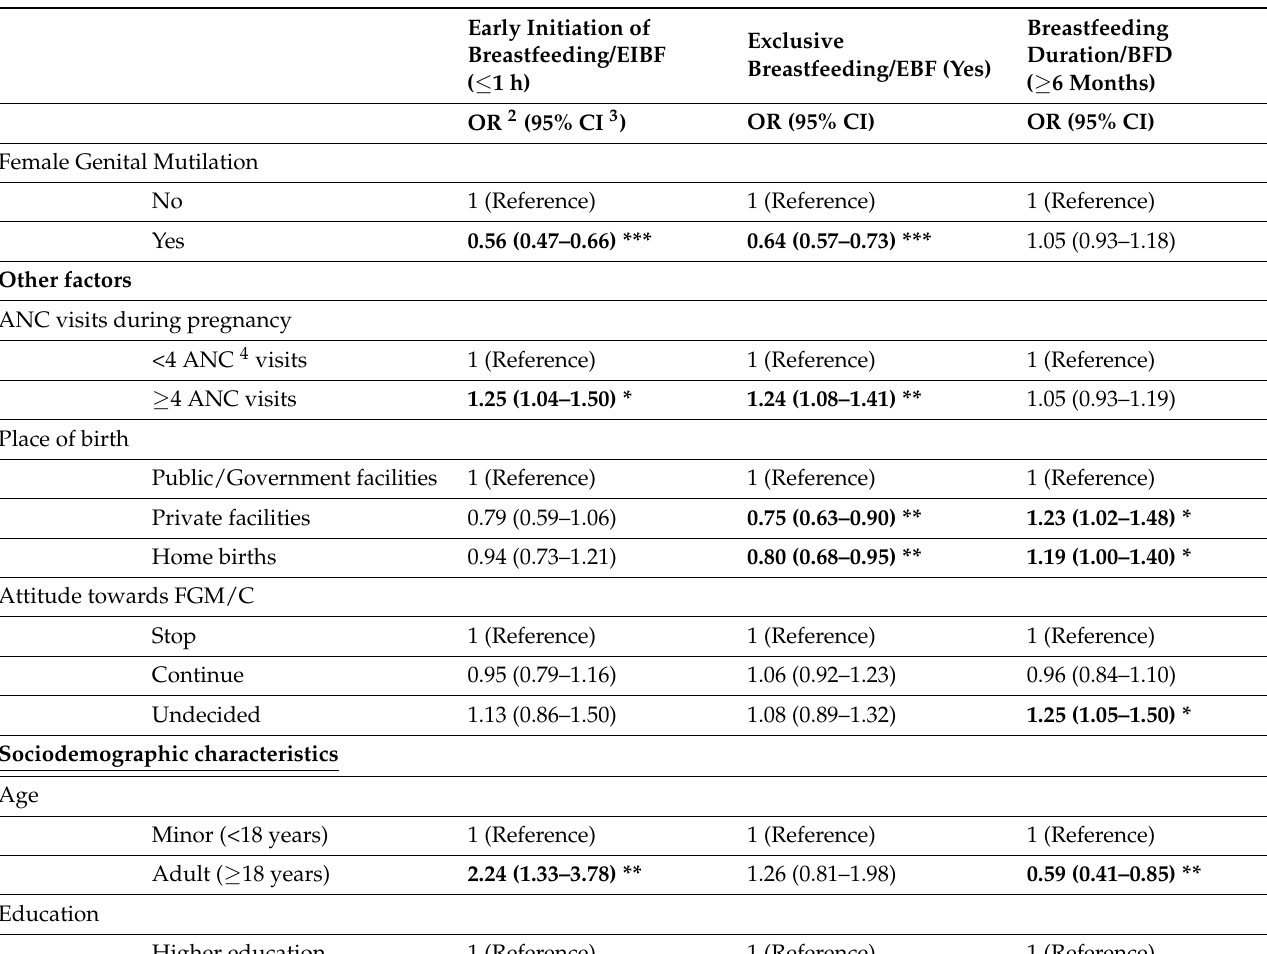
Table 2. Association between FGM/C 1 and breastfeeding outcomes in Nigerian